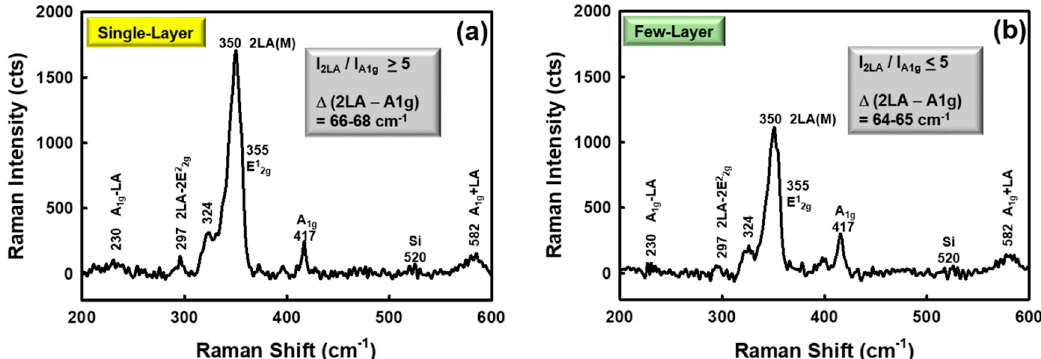
Figure 2. Typical single point Raman spectra and band assignments for different areas on a WS 2 flake on TSG. ( a ) Single-layer region. ( b ) Few-layer region.